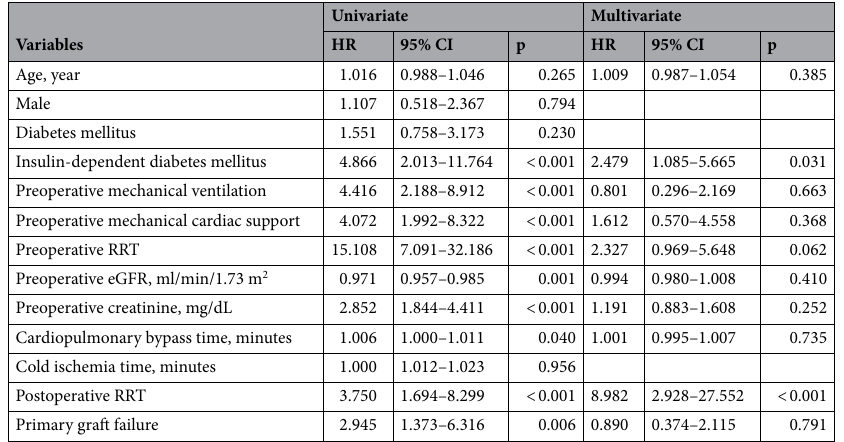
Table 3. Univariable and multivariable analysis to predict progression to dialysis-dependent ESRD after HTx. RRT renal replacement therapy, eGFR estimated glomerular filtration rate, HTx heart transplantation, ESRD end-stage renal disease.